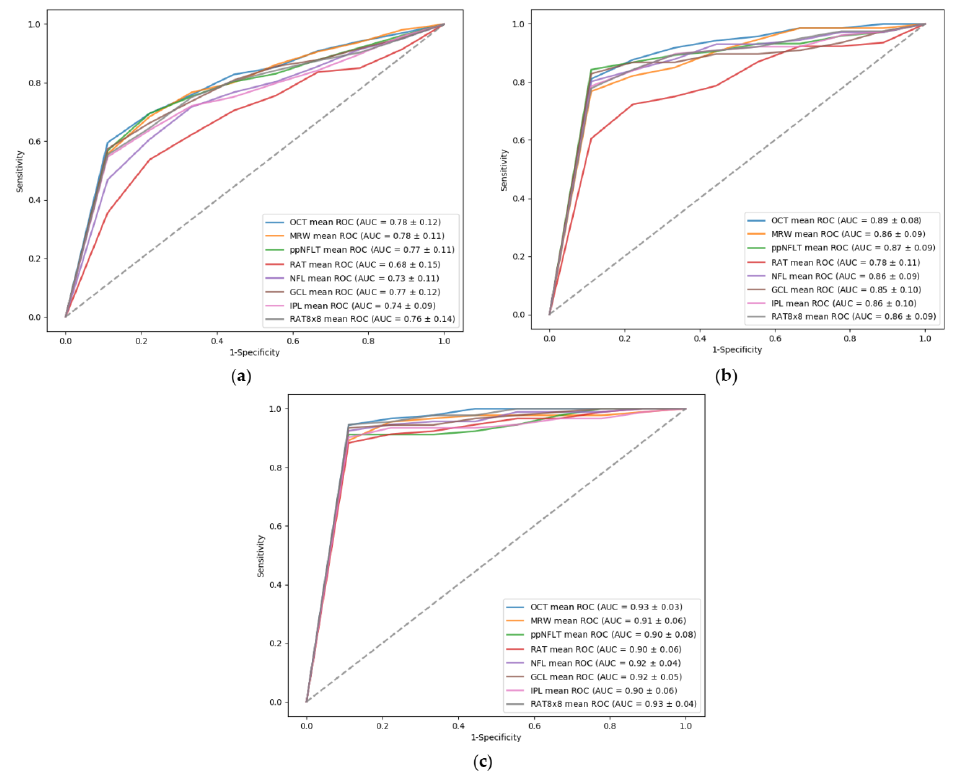
Figure 3. ROC curve of OCT-related features groups in differentiating normal from ( a ) early, ( b ) moderate, and ( c ) severe glaucomatous